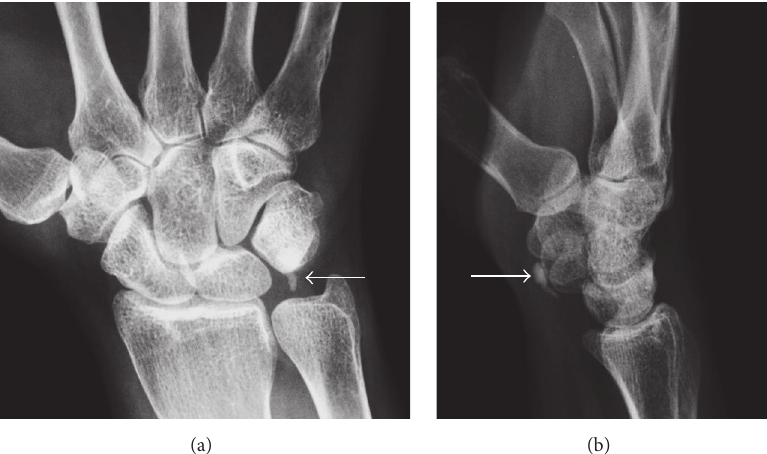
Figure 12: Calcific tendinopathy of the flexor carpi ulnaris. (a) and (b) Small conglomeration of well-defined calcifications are present just proximal to the pisiform in the expect region of the flexor carpi ulnaris insertion (arrows).